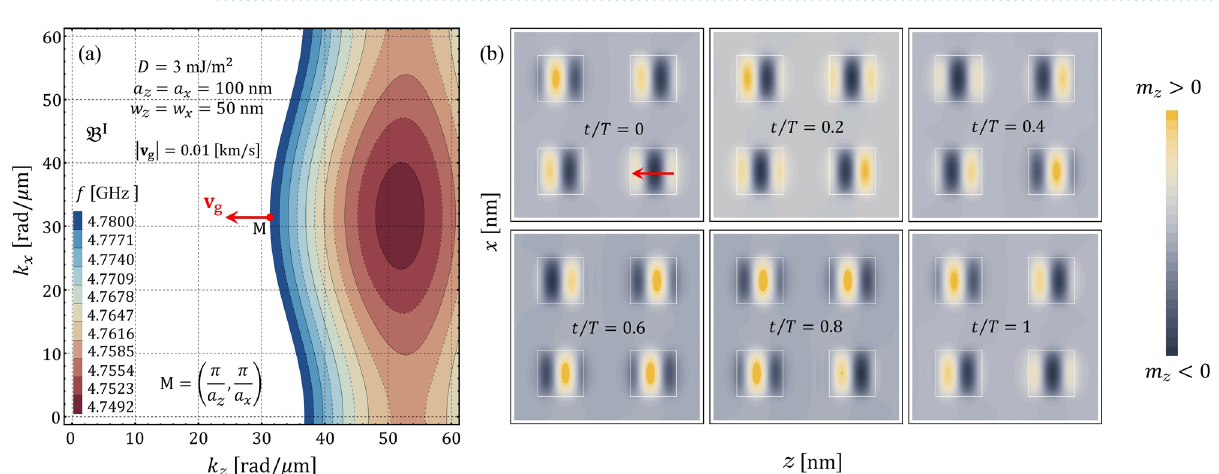
Figure 8. In ( a ), the isofrequency contour for the first band B I , evaluated at D = 3 mJ/m 2 , is depicted. In ( b ), the spatio-temporal profiles of the magnetization component m z are illustrated. Such a component is evaluated at point M of the reduced Brillouin zone and calculated in arbitrary